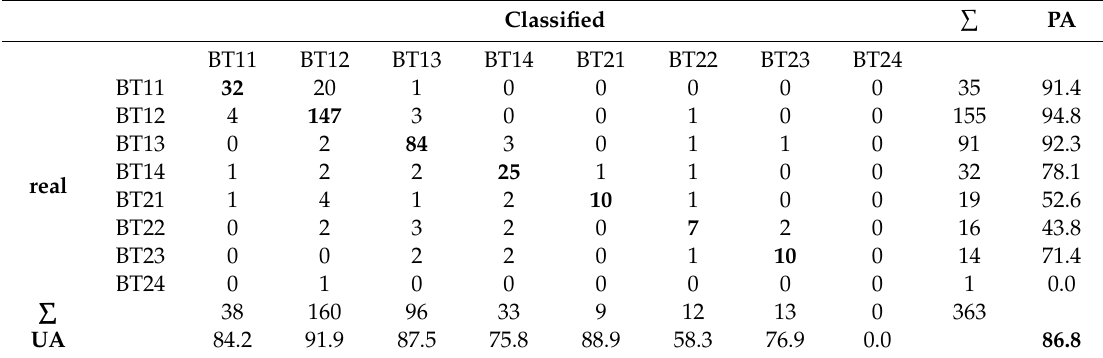
Table 5. Classification matrix of building types after the random forest